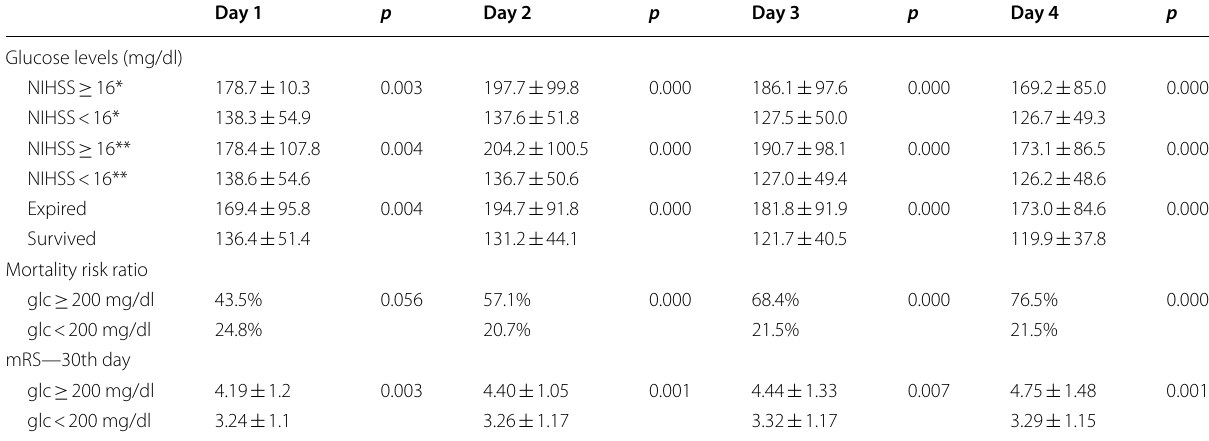
Table 3 Relationship of glucose level in the first 4 days with clinical score and prognostic